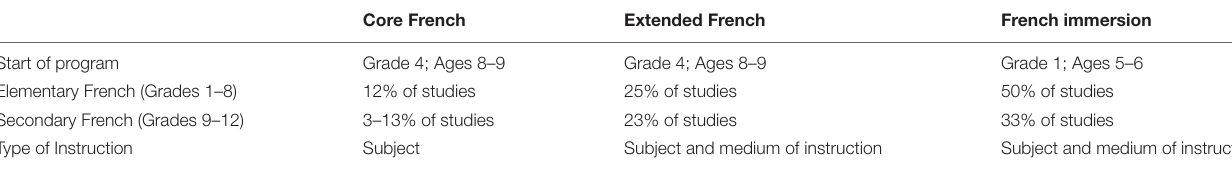
TABLE 1 | Differences in French instruction between French